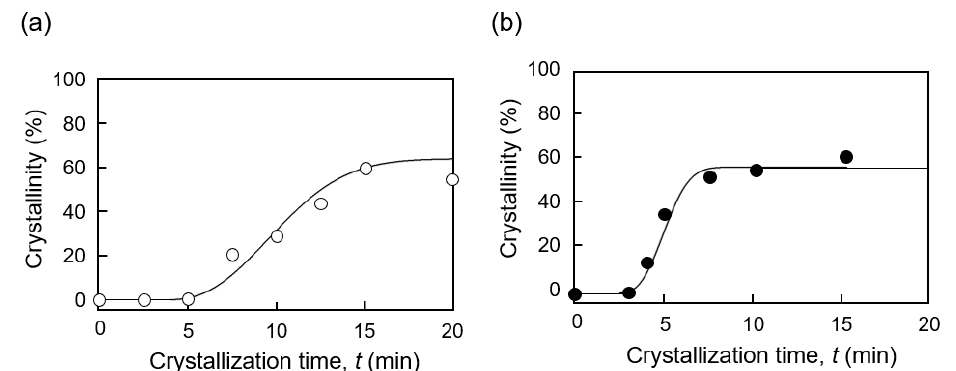
Figure 5. Crystallinity change with time determined using WAXS data. ( a ) PLLA formed in the micromolding process (i) with crystallization from the molten state. Chi-square value X 2 = 34.7. ( b ) PLLA formed in the micromolding process (ii) with crystallization from the amorphous state. Chi-square value X 2 = 20.2.